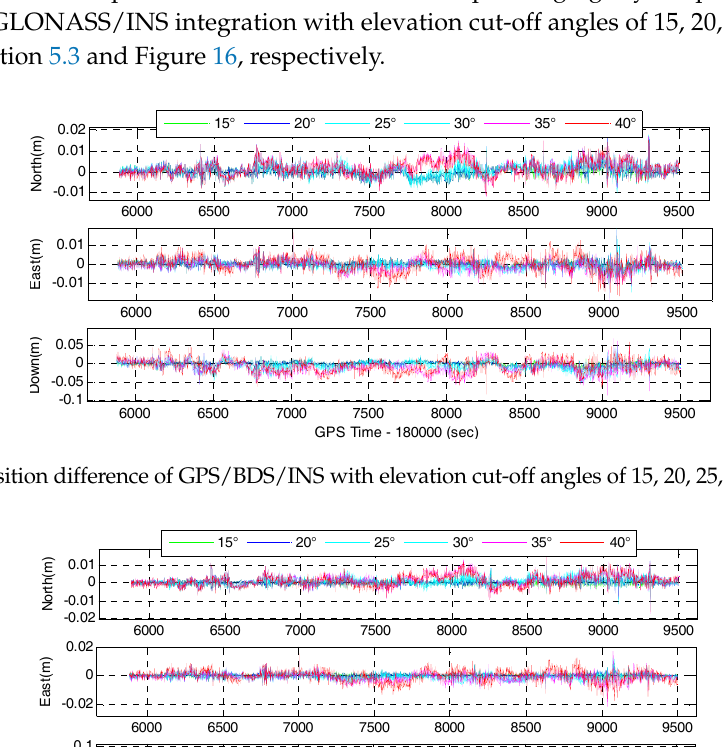
Figure 14. RMS of positioning difference of RTK for GPS/BDS/GLONASS with elevation cut-off angles of 15, 20, 25, 30, 35 and 40°.